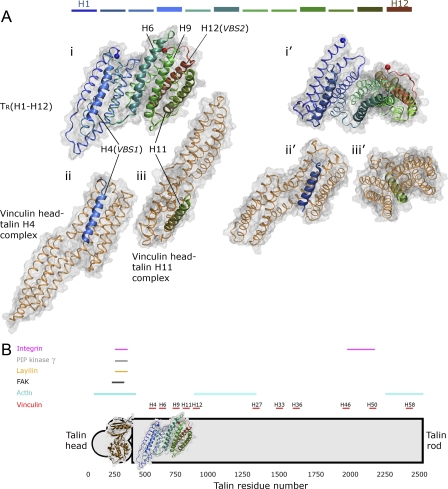
Structures of the α-Helix Bundle of Talin and of Its Vinculin Binding (VB) Helices in Complex with the Vinculin Head(A) The talin rod fragment H1–H12, which contains five VB helices. The coloring is according to residue numbers (blue, N-terminus; red, C-terminus; colors of helices are shown at the top of the figure). The VB helices H4, H6, H9, H11, and H12 are shown in bold cartoon models, and the rest of the structure is presented by narrow ribbons. The molecular surface is presented in gray (1.4 Å scanning probe used). Terminal Cα-atoms are shown as spheres. (i) Talin fragment H1–H12 (PDB 1XWX). (ii) Vinculin head domain (VH) bound to talin helix H4 (VBS1) (PDB 1SYQ). VH (brown ribbon model) is aligned onto the talin rod fragment according to talin H4 (blue cartoon model). (iii) Vinculin head domain bound to talin H11 (VBS4; PDB 1ZVZ) aligned onto the talin rod according to H11. (i'–iii') are rotated views of (i–iii).(B) Overall schematic structure of talin indicating the location of the VB helices and other protein binding sites (integrin [3,12], layilin [5], PIP kinase γ [4], focal adhesion kinase [FAK] [5], actin [11], and vinculin [10]). The structurally unresolved talin head and rod domains are shown in gray overlaid with the known structures. Few trypsin-sensitive sites in the chicken TR have been determined, maybe indicating either some local looseness of the packing in the distant C-terminal rod region even under equilibrium conditions, or high flexibility in particular loops connecting helices (known cleaving sites in TR: residue 1653, between H36 and H37; 1804, in H41) [57].